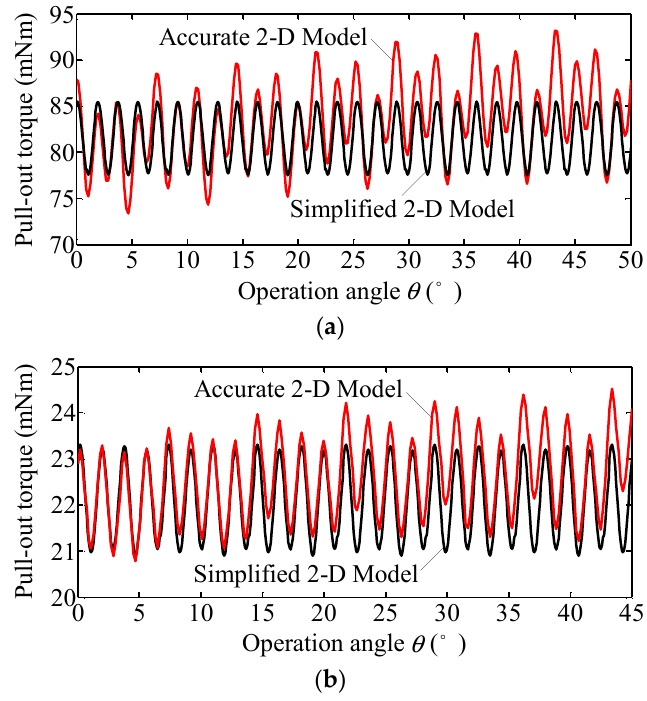
Figure 22. Maximum pull-out torque calculated by 2-D FEA with rated sinusoidal current excitation. ( a ) Sub-motor1; ( b ) Sub-motor2.